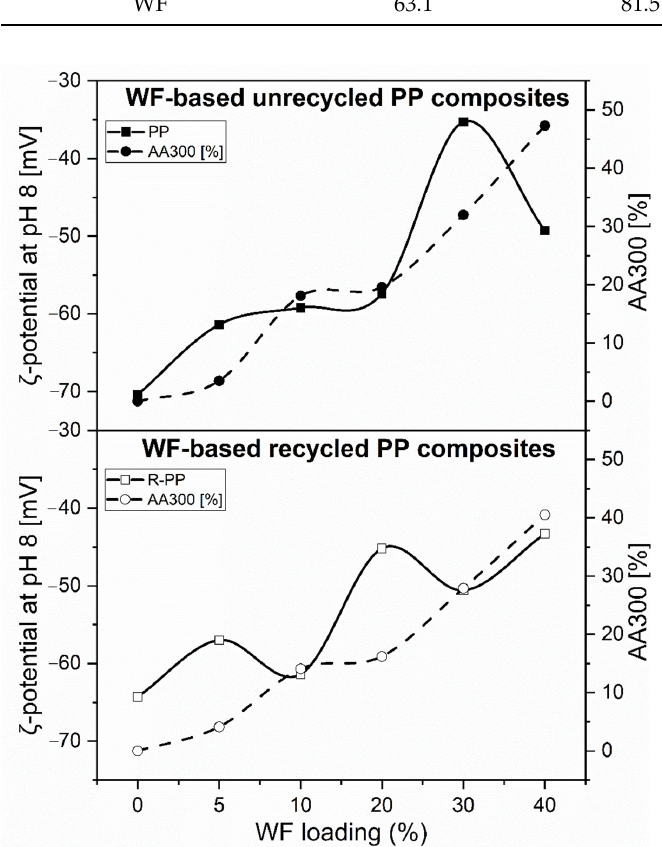
Figure 17. The correlation between negative zeta potential and an antioxidant activity of WF- PP/WF-R-PP composites. R-PP